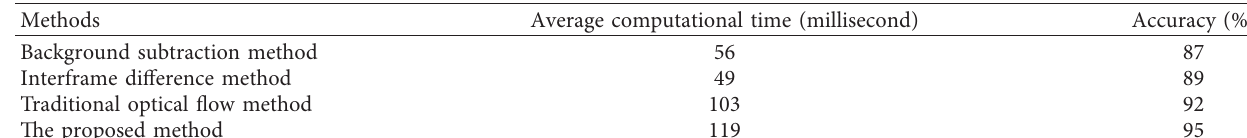
Table 1: Performance comparison of the proposed method and other methods.